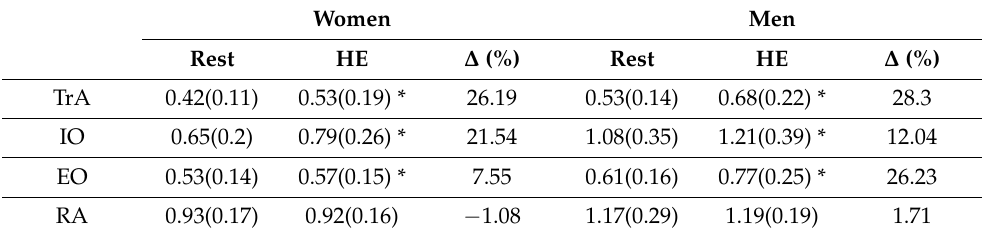
Table 3. Comparison between rest and HE in both sexes in standing (mean ±